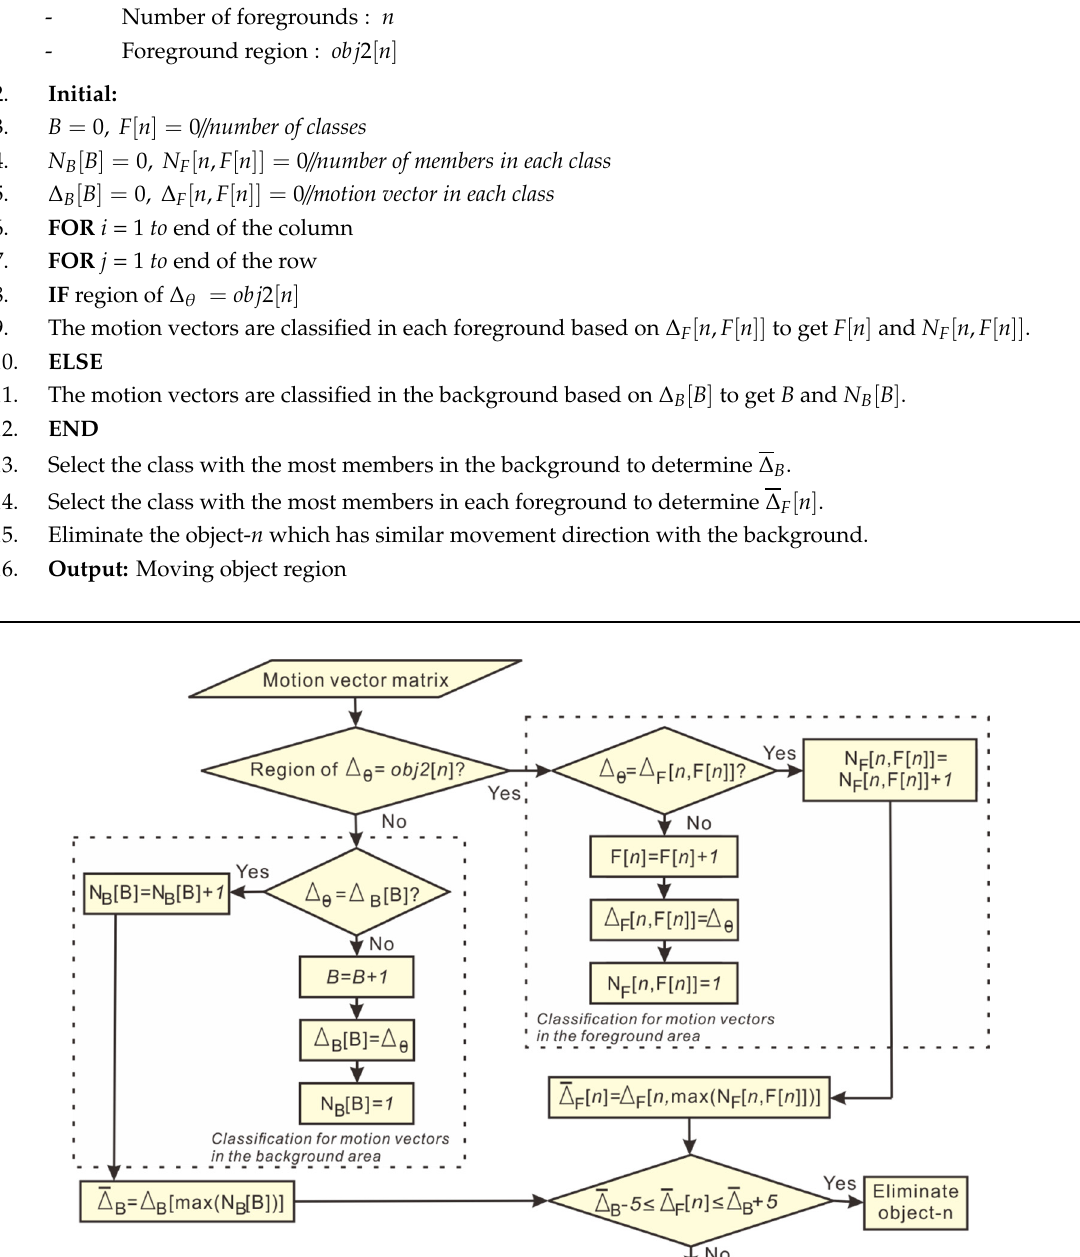
( c ) Figure 8. Result of motion vectors without image stabilization: ( a ) Background, ( b ) car, ( c ) people. Figure 9b shows that the motion vectors in the car (static object) are almost the same as the background. Figure 9c shows that the motion vectors in the people (dynamic objects) are very different from the background. Thus, the results of the motion vectors with image stabilization were very suitable to distinguish between static and dynamic objects.